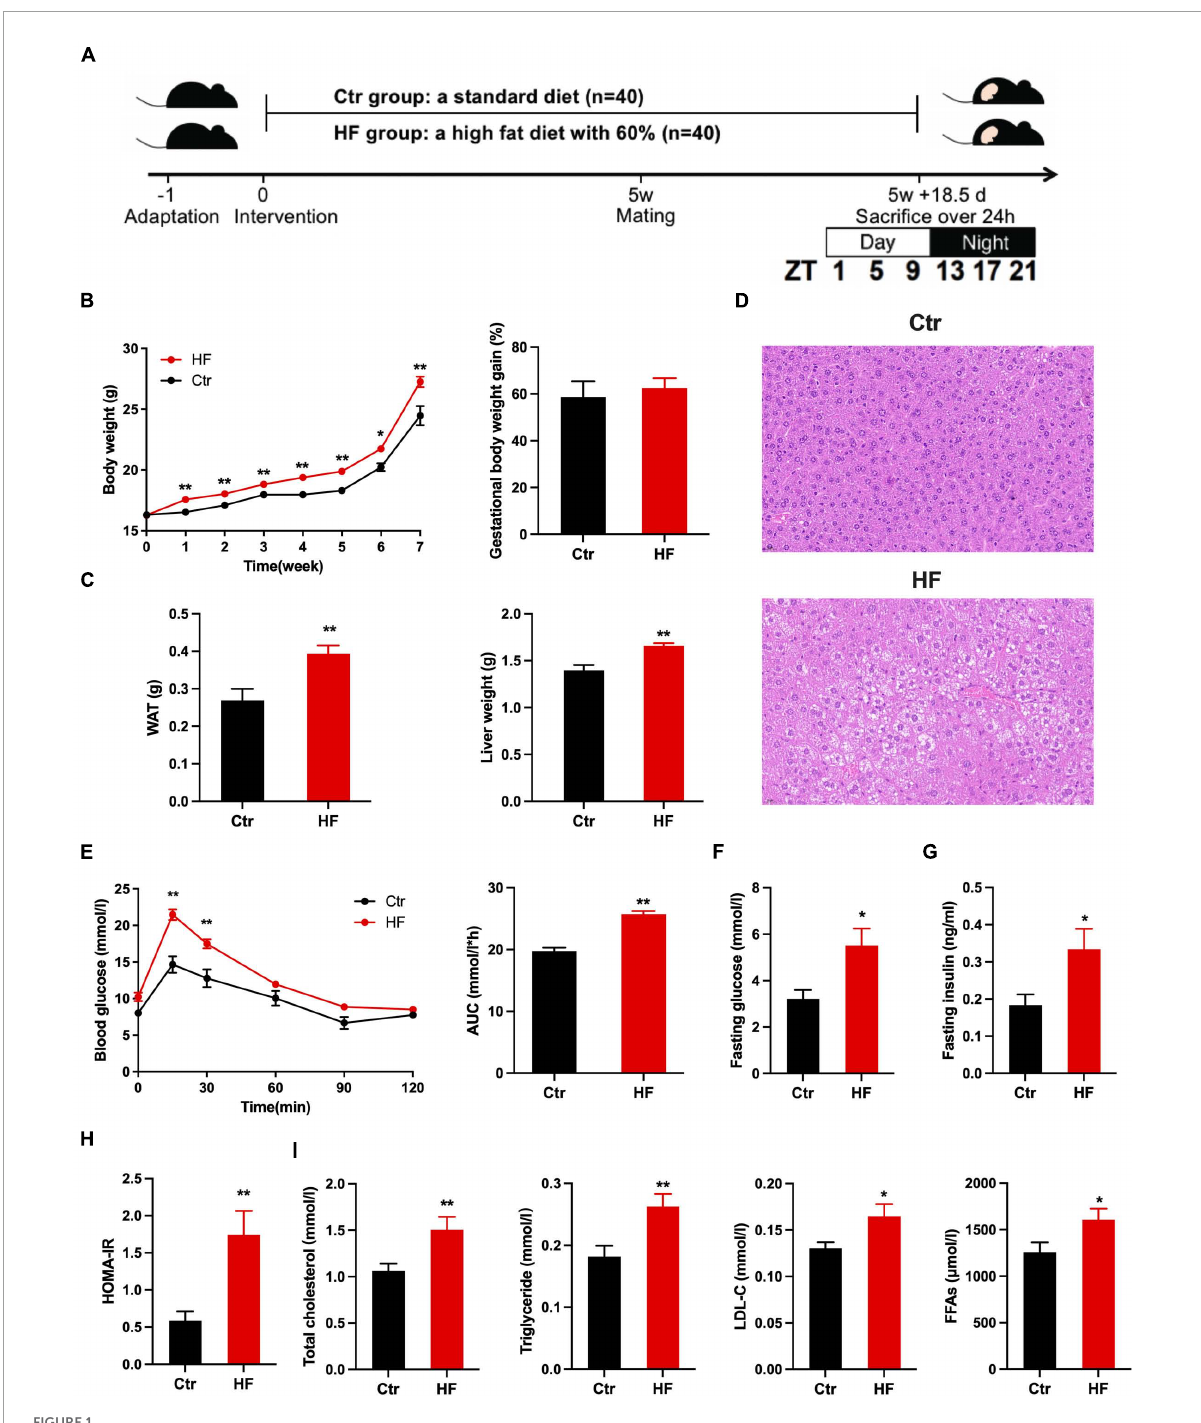
FIGURE1 High fat diet induced obesity and metabolic disorders in gestational mice. Mice were fed with a standard chow diet, or a high-fat diet prior to and throughout pregnancy. The morning of vaginal plug confirmed the pregnancy and was considered E0.5. The pregnant mice continued to feed on their respective diets until E18.5. (A) Experimental design; (B) body weight alteration during the high-fat diet treatment (left) and gestational weight gain (right); (C) weight of the WAT (left) and liver (right); (D) histological examination of liver tissues; (E) oral glucose tolerance test after fasting for 6 h (left) and the area under the curve (right); (F) fasting glucose level; (G) fasting insulin level; (H) HOMA-IR; (I) level of TC, TG, LDL-C, and FFAs. Ctr, standard chow diet-fed pregnant mice; HF, high-fat diet-fed pregnant mice; HOMA-IR, homeostasis model assessment of insulin resistance; TC, total cholesterol; TG, triglyceride; LDL-C, low-density lipoprotein cholesterol; FFAs, free fatty acids. Data are expressed as means ± S.E.M. ( n = 8–12/group). Student’s t -test and two-way ANOVA; * p < 0.05 and ** p <